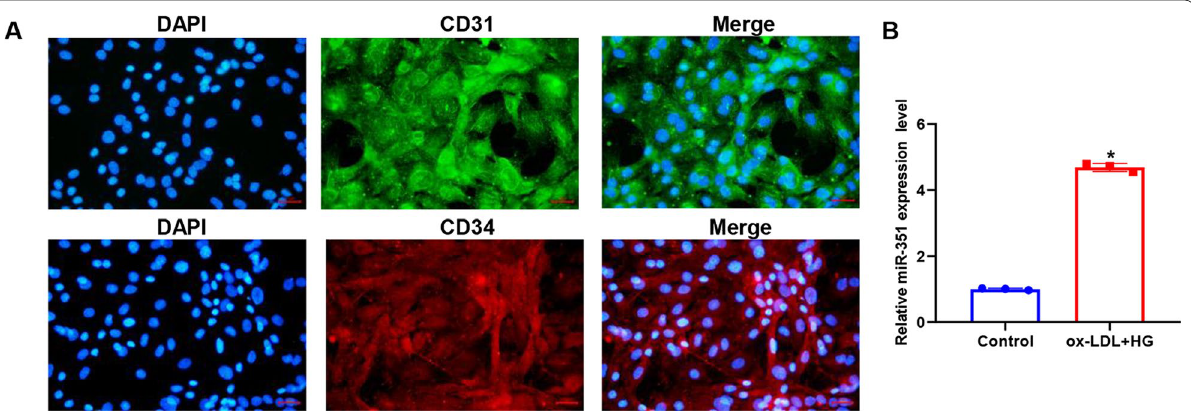
Fig. 5 Cell line construction. A CD31 and CD34 staining was performed on primary aortic cells of mice by immunofluorescence, and double-positive results indicated that primary culture of main arterial endothelial cells was successful. The scale bar represents 50 μm. B qPCR was used to detect the expression levels of ox-LDL and miR-351 in cells induced by 30 mM glucose. *P < 0.01, vs. control group. N